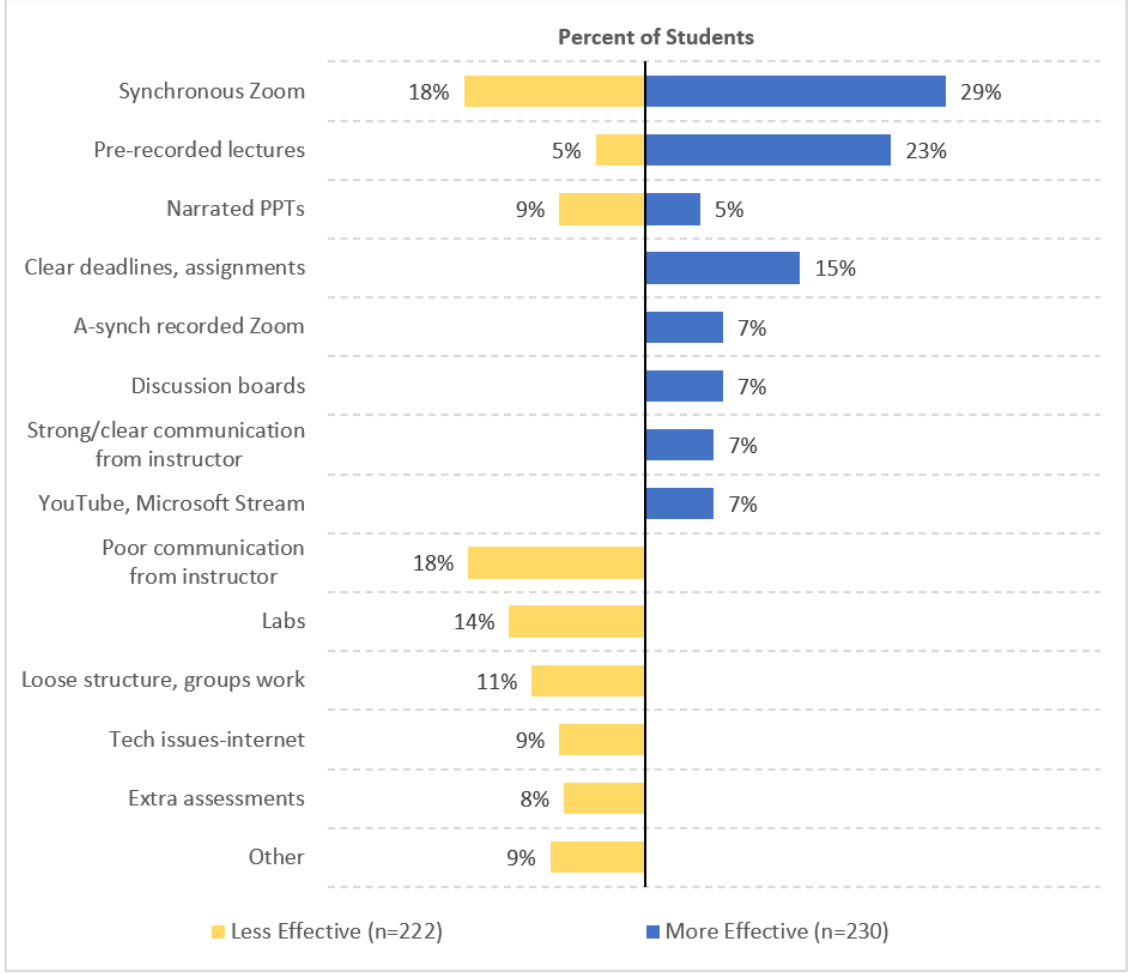
Figure 2: Student reports on instructional methods (delivery, technology, assignments, and communication from faculty) that worked the best post-COVID transition (blue bars) and those that did not work well (yellow